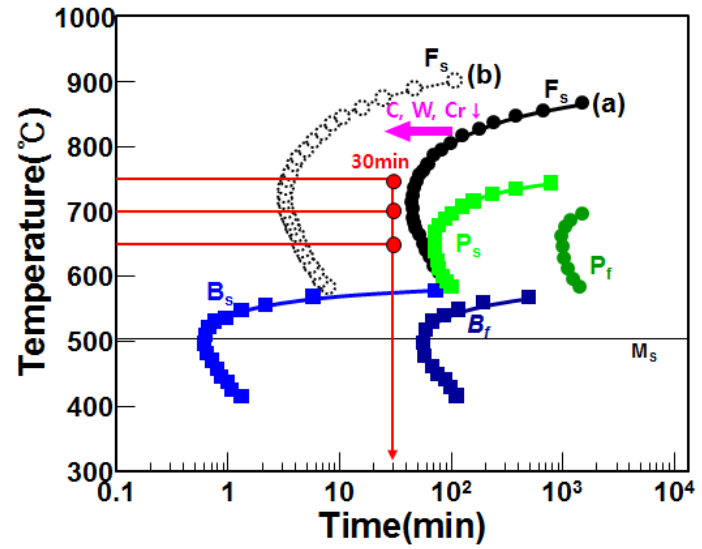
Figure 14. Time ‐ temperature ‐ transformation (TTT) diagrams for an alloy composition of matrix (Fe ‐ 0.07%C ‐ 2.09Cr ‐ 1.66W) calculated with JMatPro software. (a) Ferrite nose time of matrix alloy composition; (b) Predicted ferrite nose time when C, W, Cr is depleted.